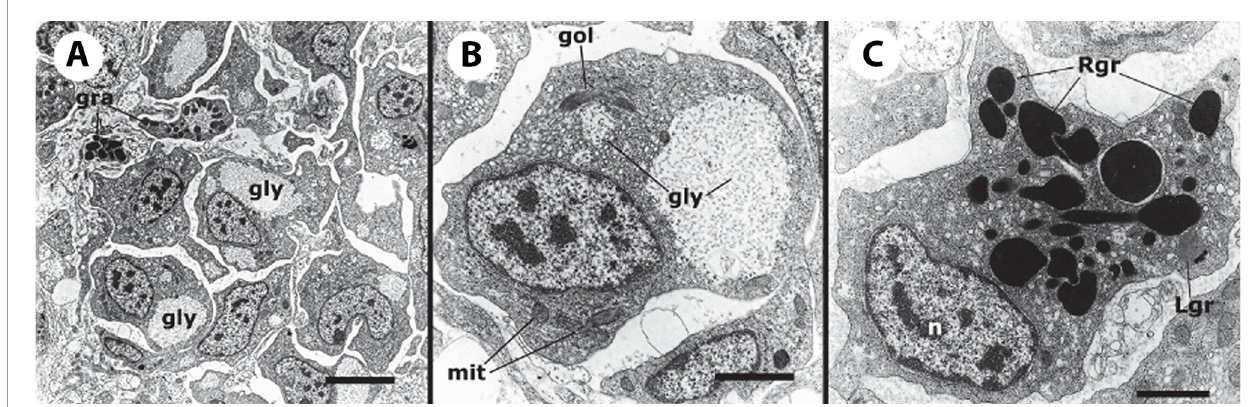
FIGURE 6 | Constitutive hemocyte islets (panels A-C, under TEM). (A) Numerous hyalinocytes and two tangential sections of granulocytes at the core of a renal islet. Non-membrane bound areas with presumptive glycogen clumps appear in most cells and are larger than those in circulating hemocytes. (B) Detail of a hyalinocyte from the preceding panel, showing a Golgi stack, areas of presumptive glycogen clumps, SER vesicles and mitochondria. (C) A granulocyte in a renal islet, showing SER vesicles, some RER pro fi les and numerous R granules of different sizes (some of them appear merging); a single L granule is also seen. Microgranular material and membrane remnants are found in the intercellular space.AGR, agranulocyte; GLY, presumptive glycogen granules; GOL, Golgi stack; GRA, granulocyte; HYA, hyalinocyte; LGR, L granule; RGR, R granule. Scale bars in (A, B) panels represent 5 m m, while those in other panels represent 1 m m. From (41).